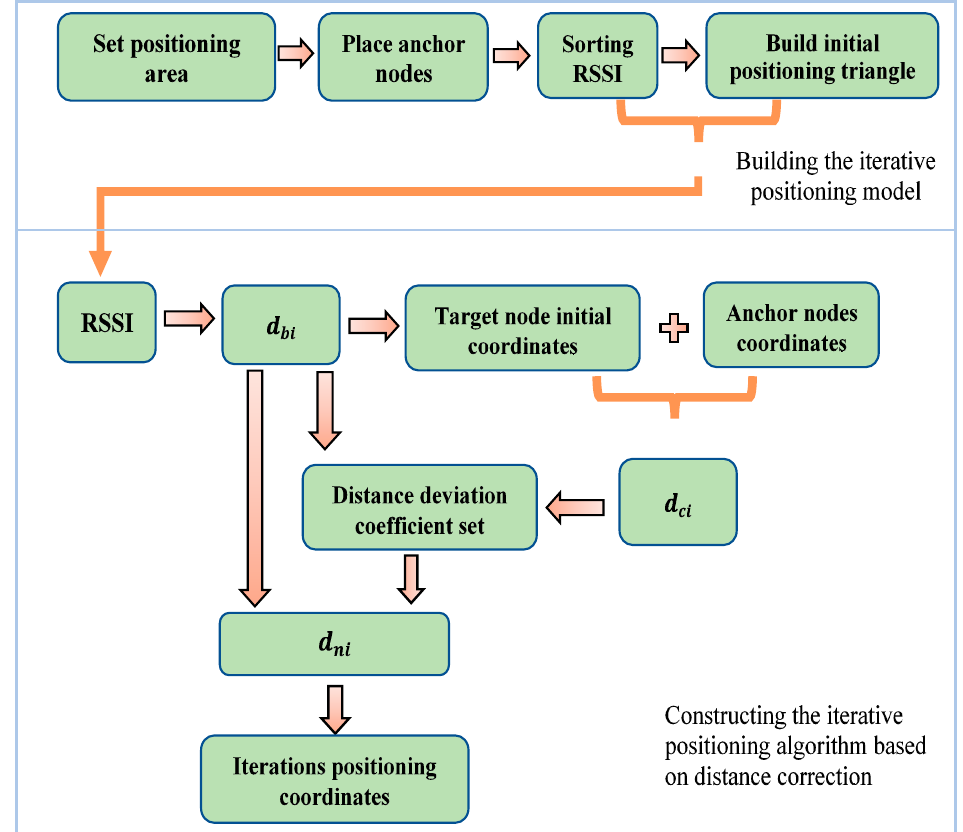
Figure 1. The process of our target node iterative positioning model based on distance correction. The d bi is the distance between the given anchor node and unknown target node, which is calculated by the log-distance distribution model in Figure 1. The d ci is the distance between the coordinates of the anchor node and the coordinates calculated by the triangle centroid positioning algorithm. The d ni is the distance between the anchor node and the target node, which is recalculated based on the median. Legend: RSSI, received signal strength indication.